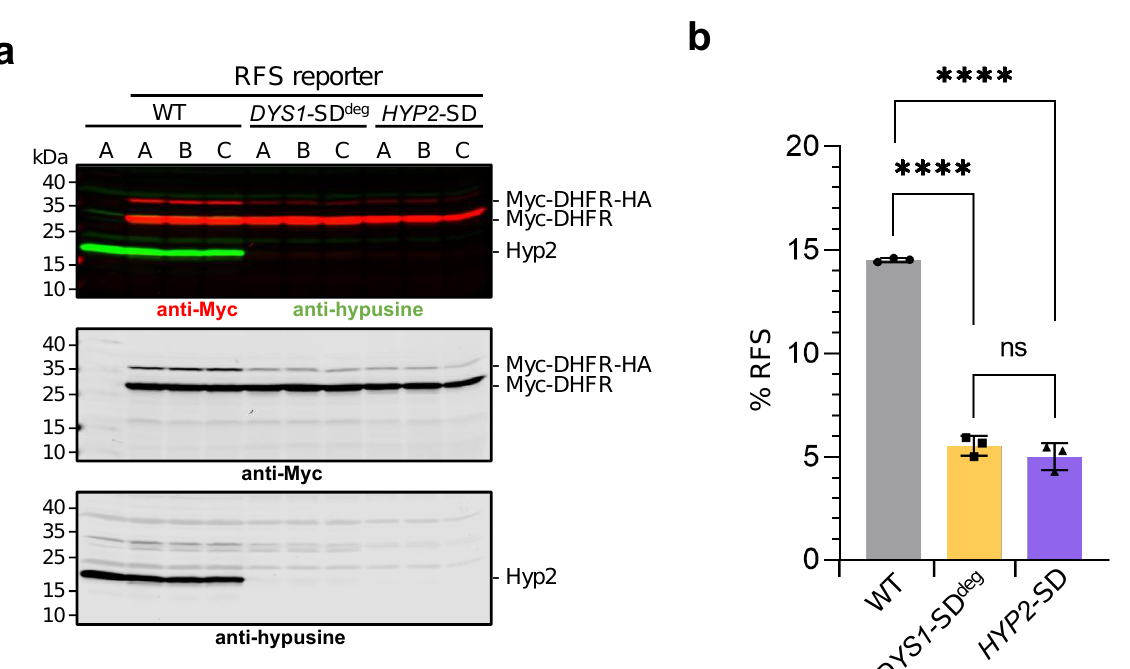
Figure 4. DYS1 and HYP2 shutdown leads to an inhibition of OAZ1 ribosomal frameshifting. ( a ) Western blot analysis of RFS reporter levels in the indicated shutdown (SD) strains compared to the wild type (WT). The WT and the P GAL1 -tc3-HA-HYP2 ( HYP2 -SD) strains were incubated for 8 h in YPD with 250 µM tetracycline. The P GAL1 -tc3-UB-R-HA-DYS1 ( DYS1 -SD deg ) strains were incubated for 20 h in the same media with sequential dilutions to prevent entry into stationary phase due to nutrient deprivation. The experiment was performed with three independent isogenic spore clones (A, B, C) for each genotype. To confirm the specificity of the reporter detection by the Myc antibody, a WT strain without RFS reporter was analyzed as a control (first lane). Extract proteins were analyzed by SDS-PAGE and western blotting with simultaneous detection of Myc (red) and hypusine signals (green) (top panel). The middle and bottom panels show the individual signals in grayscale. ( b ) Shown is a quantitative analysis of ratios of the signals for the full-length reporter resulting from ribosomal frameshifting to the signals for the shorter reporter resulting from premature translation termination at the internal STOP codon. The relative amounts of the full-length reporter (in % of the total Myc-DHFR signal) are depicted as % RFS. Individual values are shown as dots, squares, or triangles. The bars represent the means of values obtained from the three independent spore clones analyzed for each genotype in ( a ). Standard deviations (SD) are indicated by error bars. Four asterisks indicate significant differences with p -values < 0.0001; ns, not significant. Statistical significance was determined with unpaired and two-sided Student’s t -tests. Numbers obtained from signal quantification and calculation of SD and significance are shown in Table S1. The full-size blot and total protein stain loading control are shown in Supplementary Figure S1.